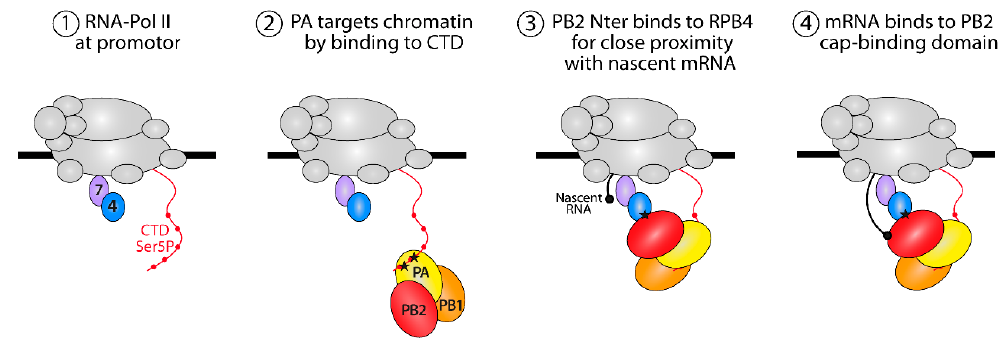
Figure 7. Proposed model for the interaction interplay between FluPol and Pol II. Pol II is represented in gray with RPB4 and RPB7 subunits in blue and lavender, respectively. FluPol first recognizes the YSPTSpPS motifs (with the serine phosphorylated at position 5 indicated by red dot) in the CTD of RPB1 to bind the RPB4 subunit located at the vicinity of the Pol II pore which extrudes nascent mRNA during transcription. PB2 binds the cap (black dot) of the mRNA by its cap-binding domain. Black asterisks indicate FluPol binding sites on the Pol II CTD and RPB4. What could the time-line of the FluPol-RPB4/RPB7 dimer interaction be? Nascent